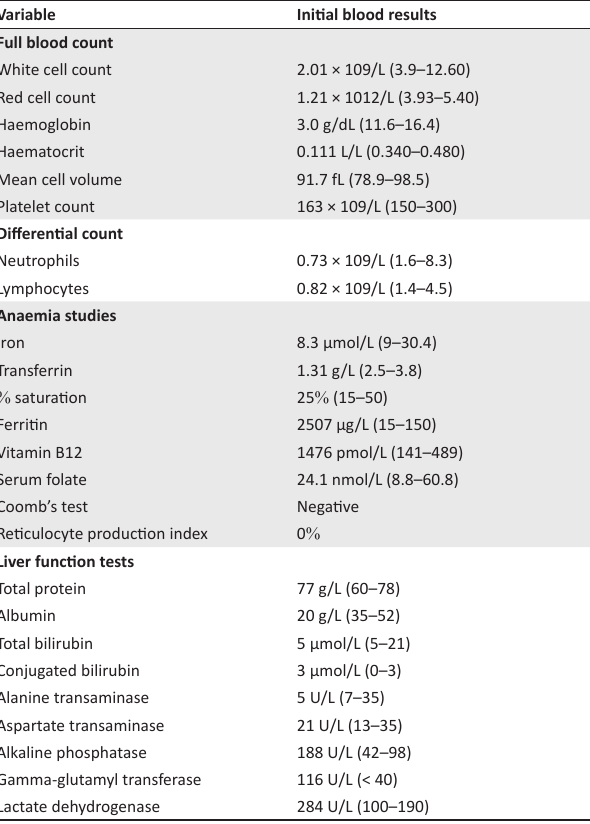
TABLE 1: Initial blood results.